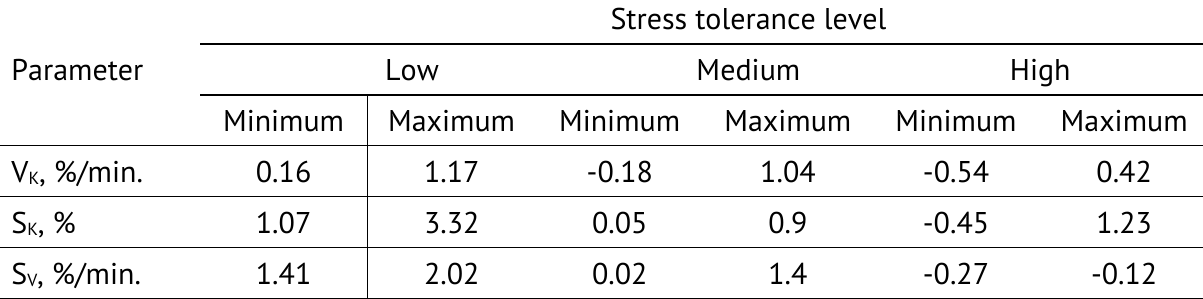
The evaluation results of the attention parameters of individual probationers in